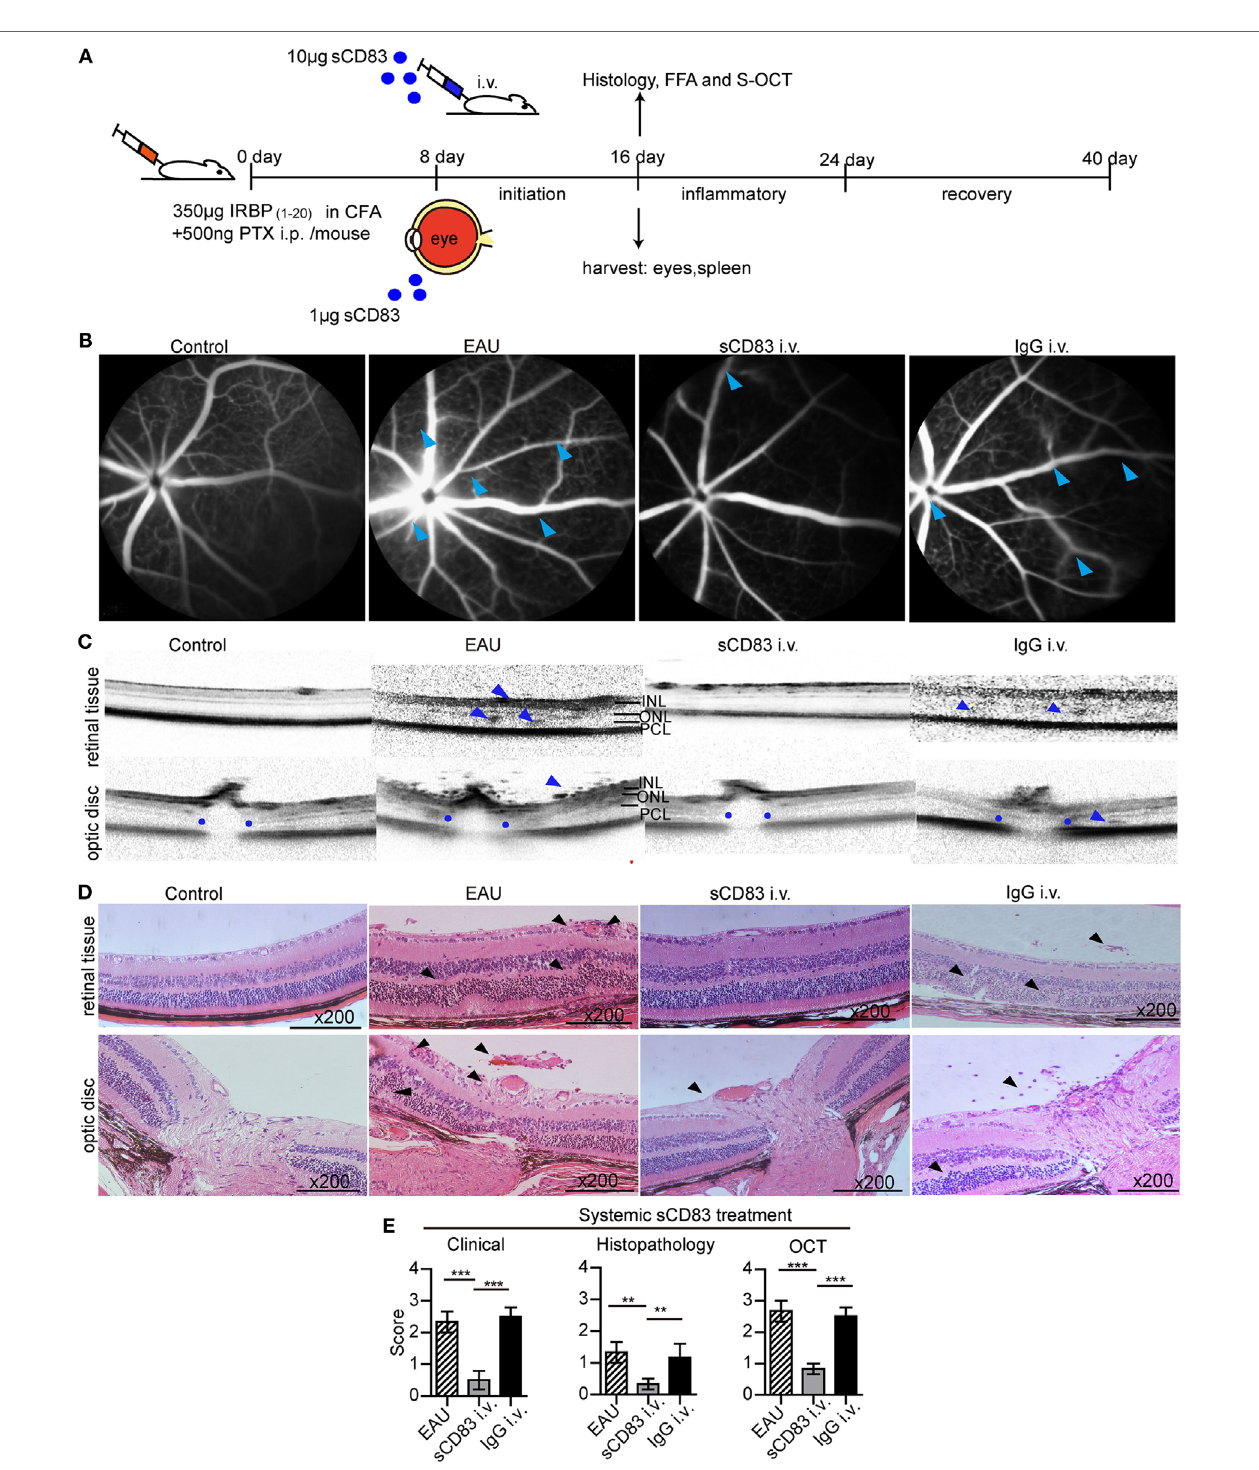
FigUre 2 | Soluble CD83 (sCD83) treatment ameliorates experimental autoimmune uveitis (EAU). (a) Protocol of the sCD83 treatment scheme during EAU. (B–D) Representative images from a control, EAU, i.v. sCD83-treated, and i.v. IgG 1 -treated mouse as assessed by (B) fundus fluorescein angiography, (c) spectralis optical coherence tomographic (S-OCT) scans, and (D) histology. Leaks and lacks of hyperfluorescence at the optic disk are marked [blue arrows in (B) ]. Dark blue arrows in (c) , point to dome-shaped signals at the subretinal space. Blue dots point to the boundary of the outer plexiform layer of the optic disk. INL, inner nuclear layer; ONL, outer nuclear layer; PCL, photoreceptor cell layer. (D) H&E stainings of the retina at 200 × magnification. Black arrows mark swollen blood vessels, infiltrating lymphocytes, and retinal disorganization. Scale bar = 100 μ m. (e) The histopathological, clinical, and OCT scores were evaluated in EAU, sCD83-treated, and IgG 1 -treated mice. Mean ± SEM, n = 3 in triplicates, one-way ANOVA LSD- t test. *** p < 0.001, ** p < 0.01.